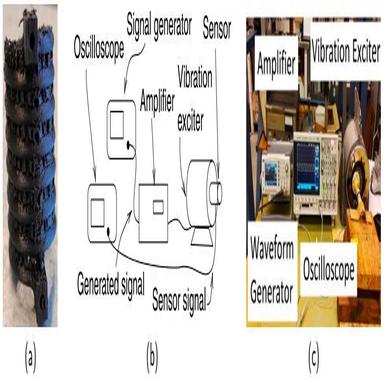
a) Printed coil with supports; b) components of the experiment; c) experimental setup.